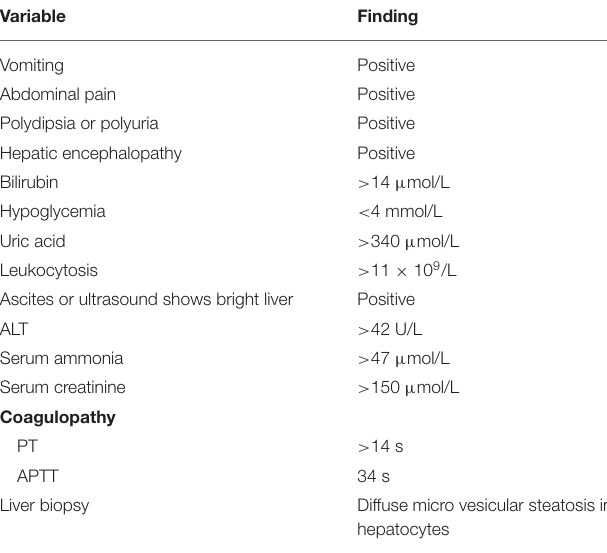
TABLE 1 | Swansea criteria for diagnosis of